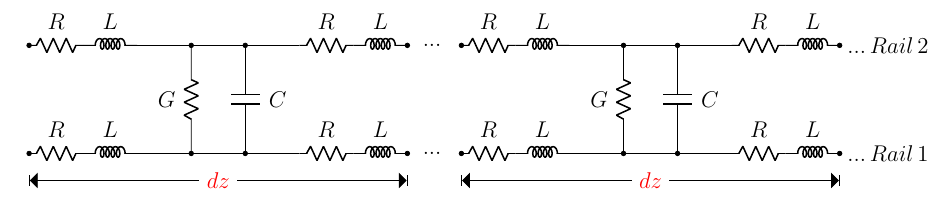
Figure 4. Lossy transmission line model with distributed